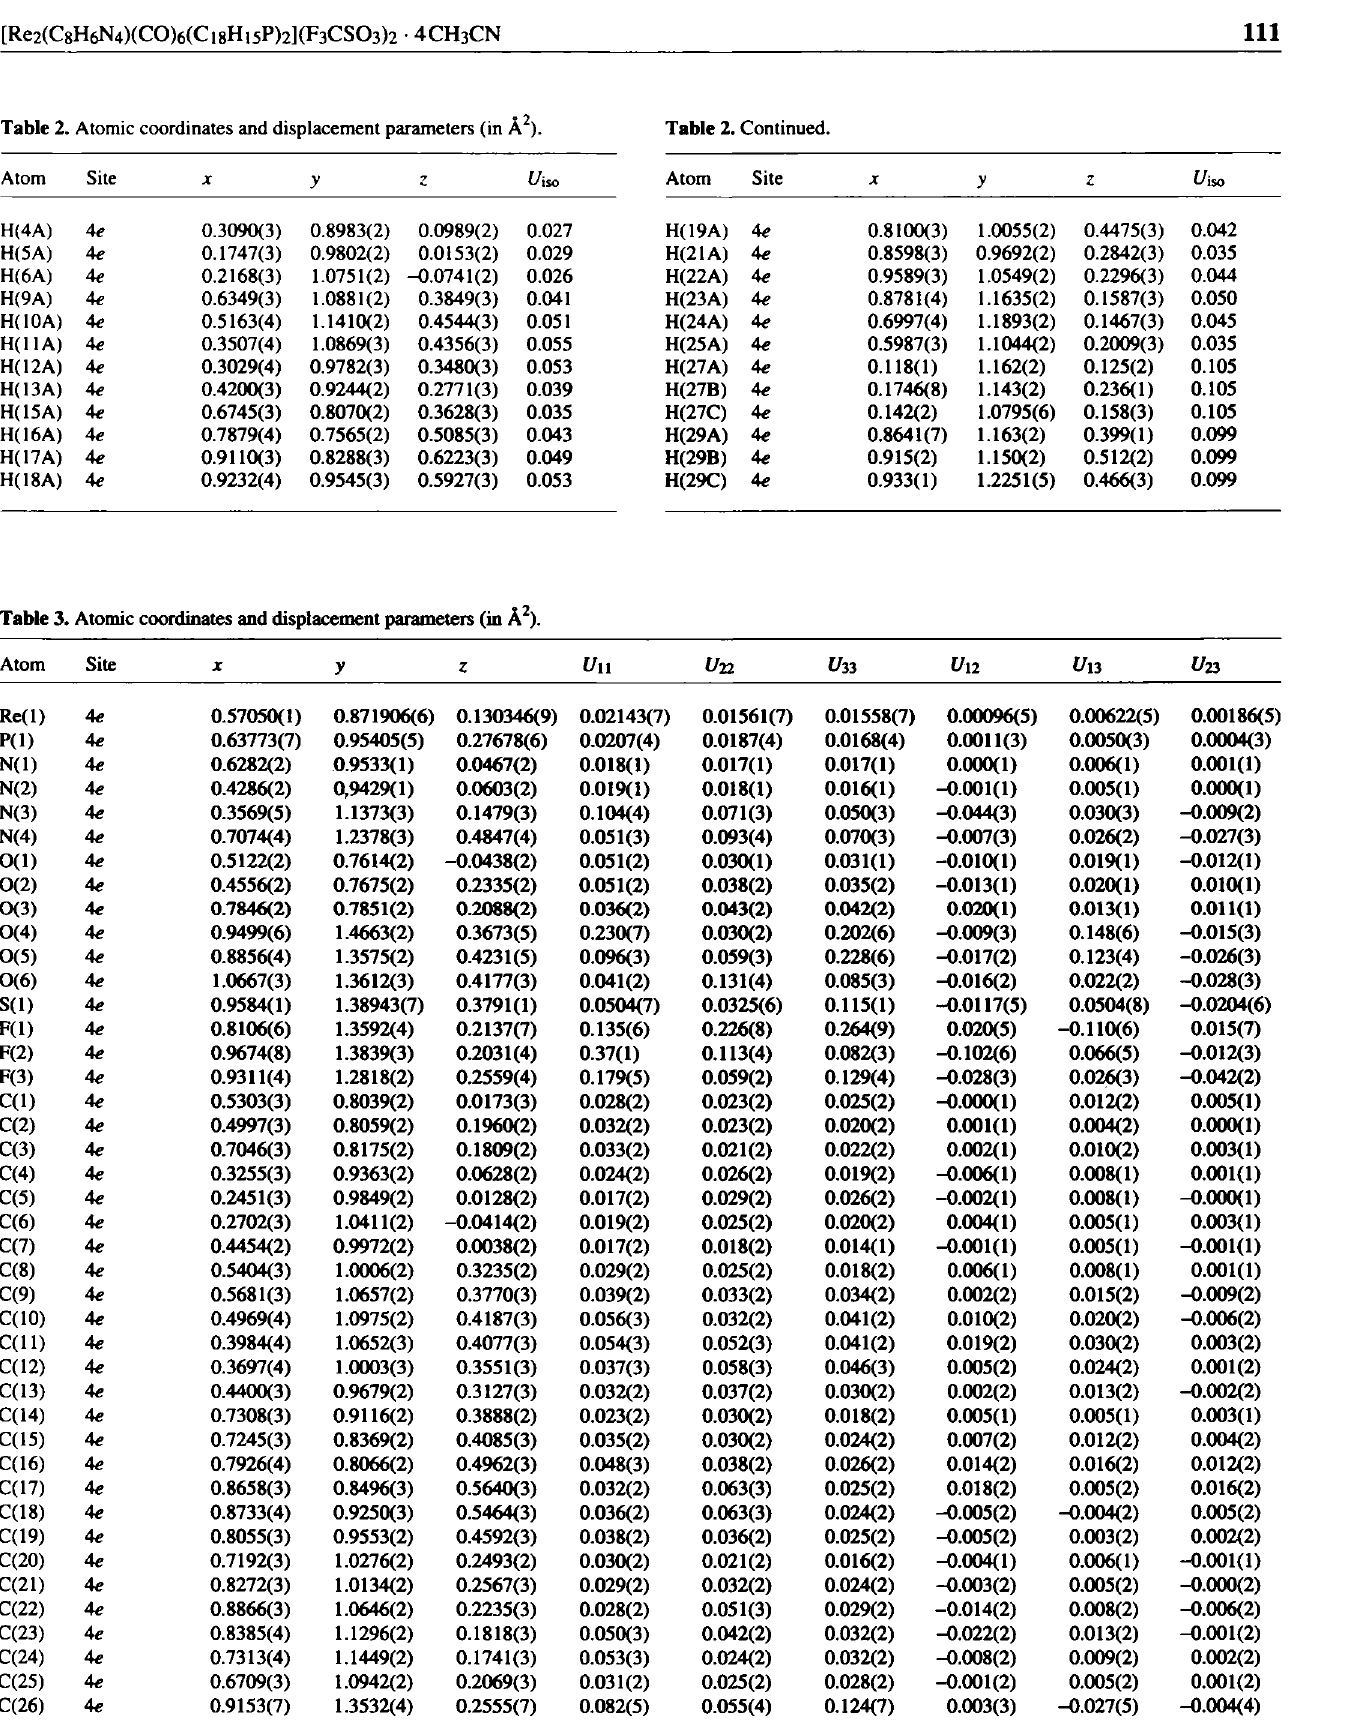
Table 2. Atomic coordinates and displacement parameters (in A 2 ). Table 2. Continued.